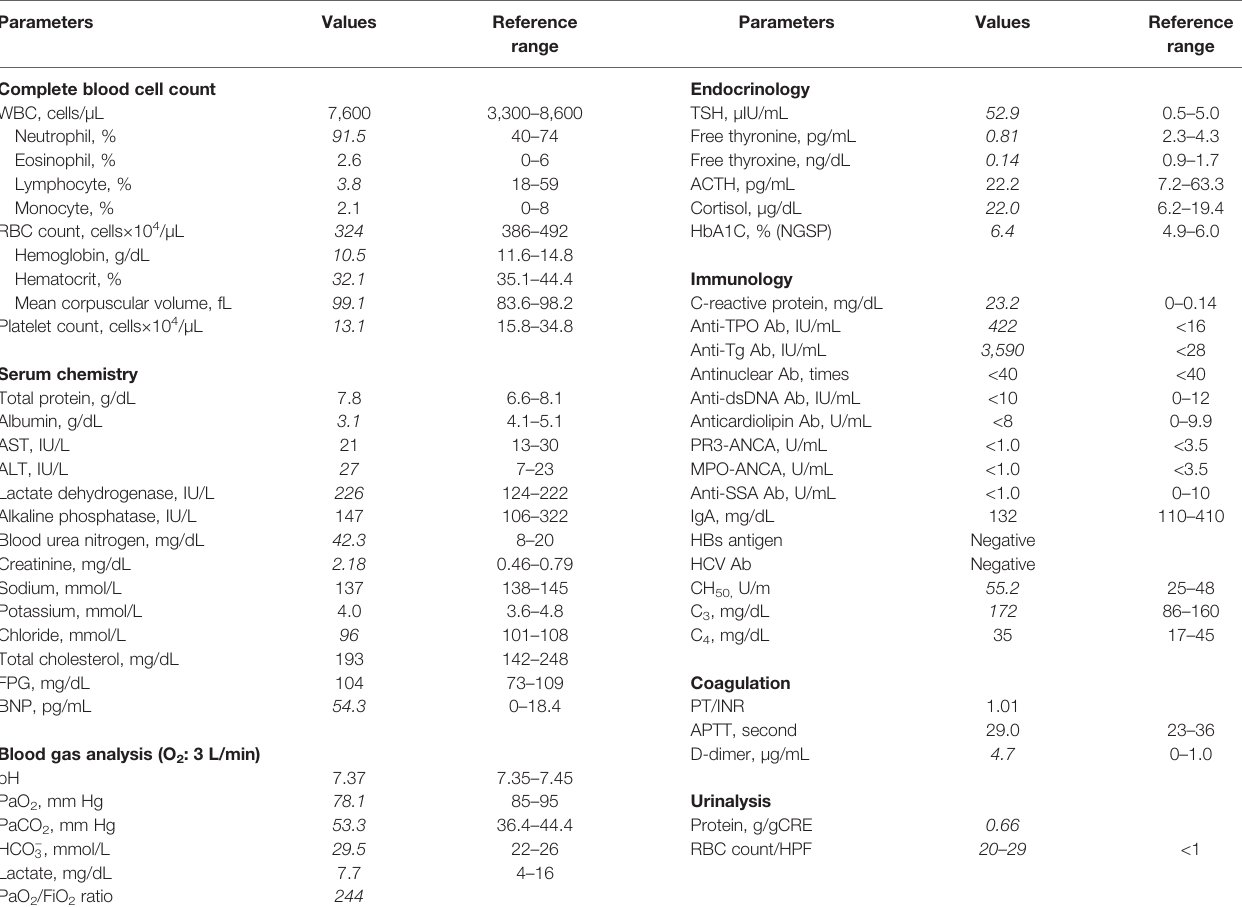
TABLE 1 | Laboratory data on